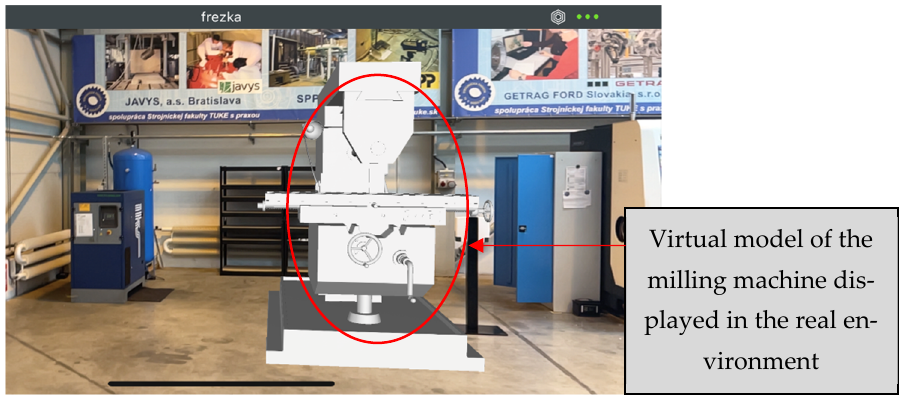
Figure 13. Display of the digital model of the milling machine in the real environment.